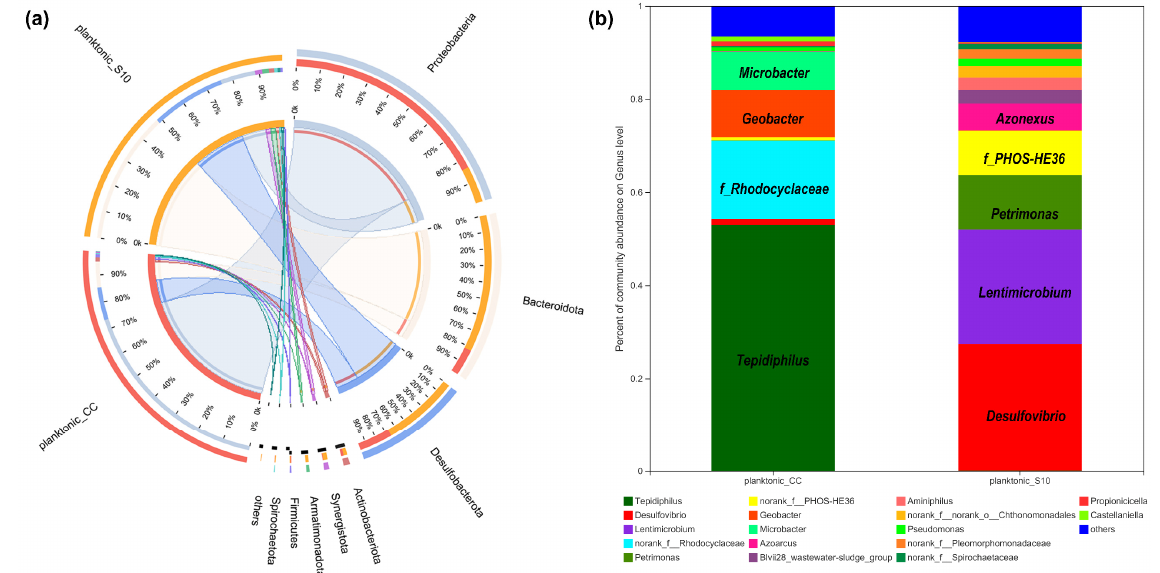
Figure 4. The relative abundance of microbial community compositions of planktonic_CC and planktonic_S10 at the phylum ( a ), and genus level ( b ), respectively.